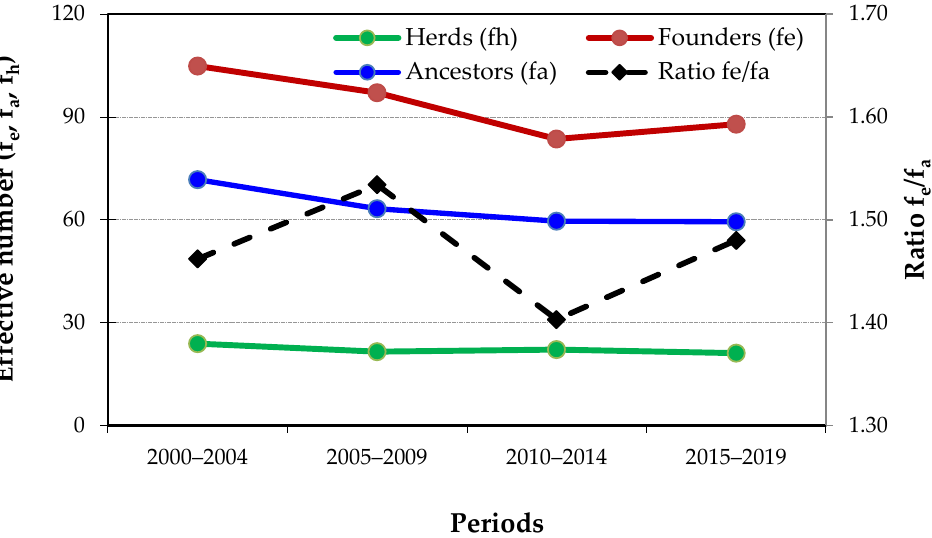
Figure 11. Evolution of effective number of founders, ancestors, herds and ratio f e /f a in 5-year periods.